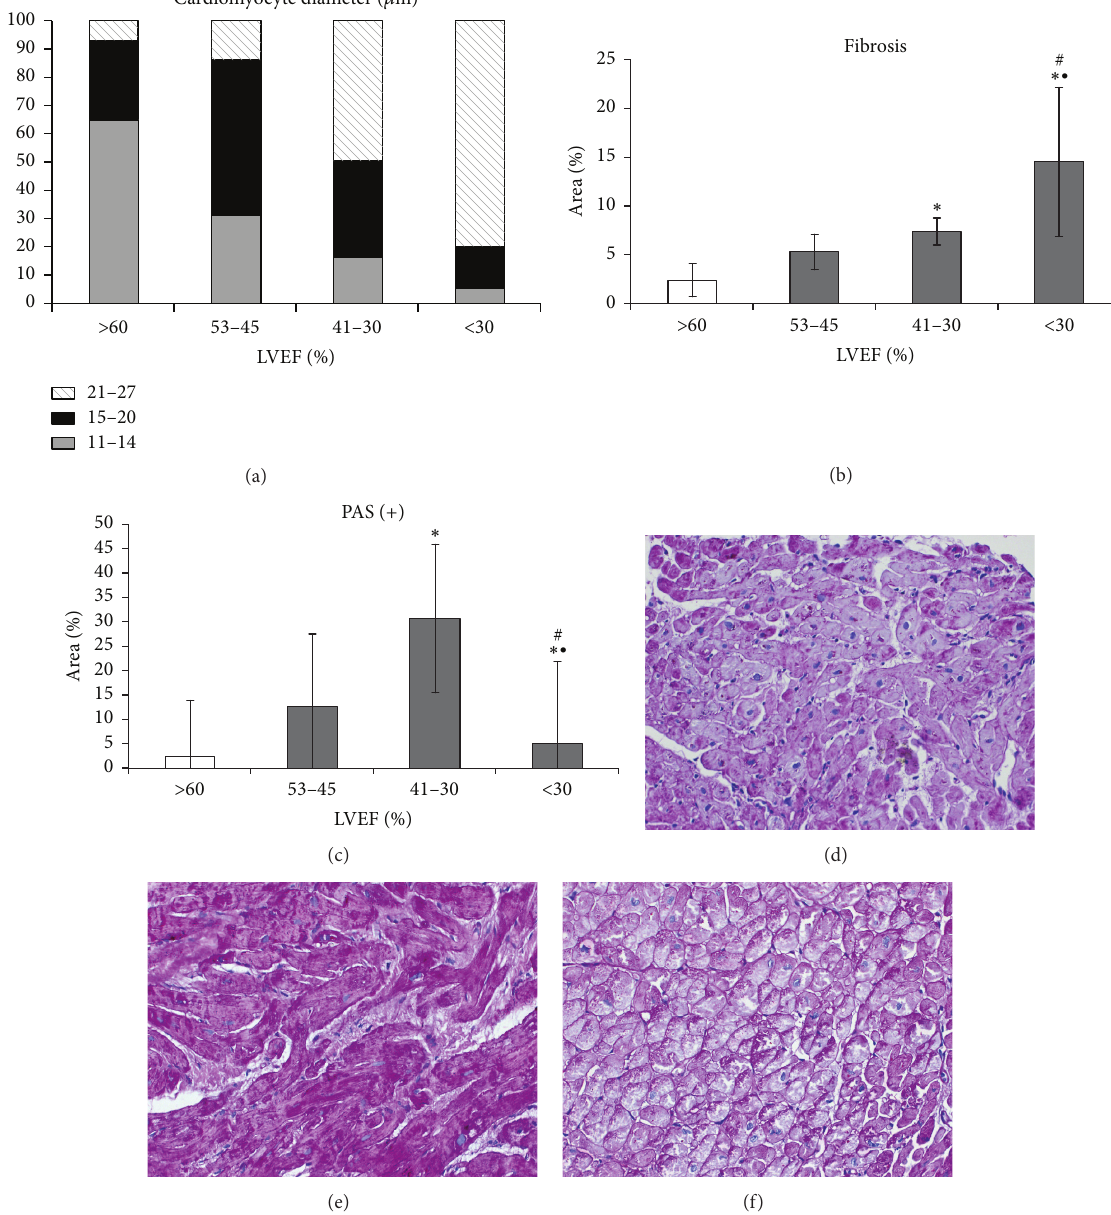
Figure 2: Results of morphometric analyses in tissue section: (a) cardiomyocyte hypertrophy; (b) fibrosis; (c) PAS-positive area; results as mean ± SEM; ∗ 𝑝 < 0.05 versus control; # 𝑝 < 0.05 versus Group (I); ∙ 𝑝 < 0.05 versus Group (II); representative images of PAS-stained endomyocardial tissue sections from hearts with (d) LVEF 53–45%, (e) LVEF 41–30%, and (f) LVEF <